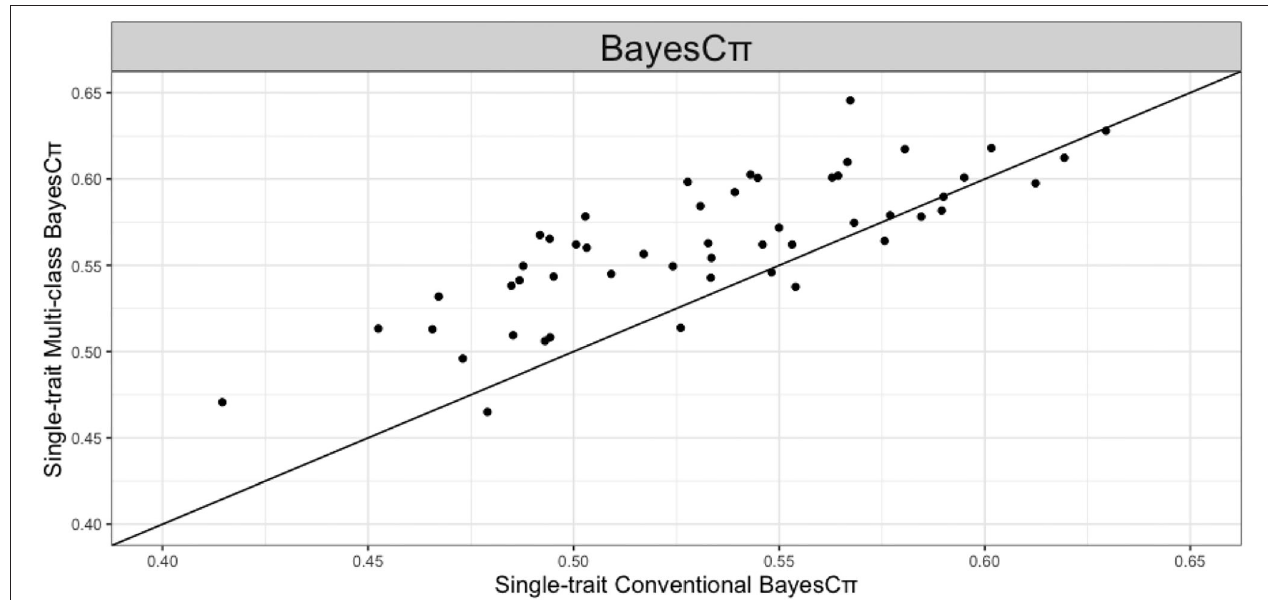
FIGURE 5 | The pairwise prediction accuracy comparisons of conventional BayesC π and multi-class BayesC π using chromosome classes for the trait 13-week tenth rib backfat (mm) of real pig data. The x-axis represents the genomic prediction accuracy obtained from conventional BayesC π ; the y-axis represents the genomic prediction accuracy obtained from multi-class BayesC π ; the diagonal line is used for reference such that a dot above the line represents a validation with higher accuracy for multi-class BayesC π . Multi-class BayesC π significantly outperformed the conventional BayesC π ( p <